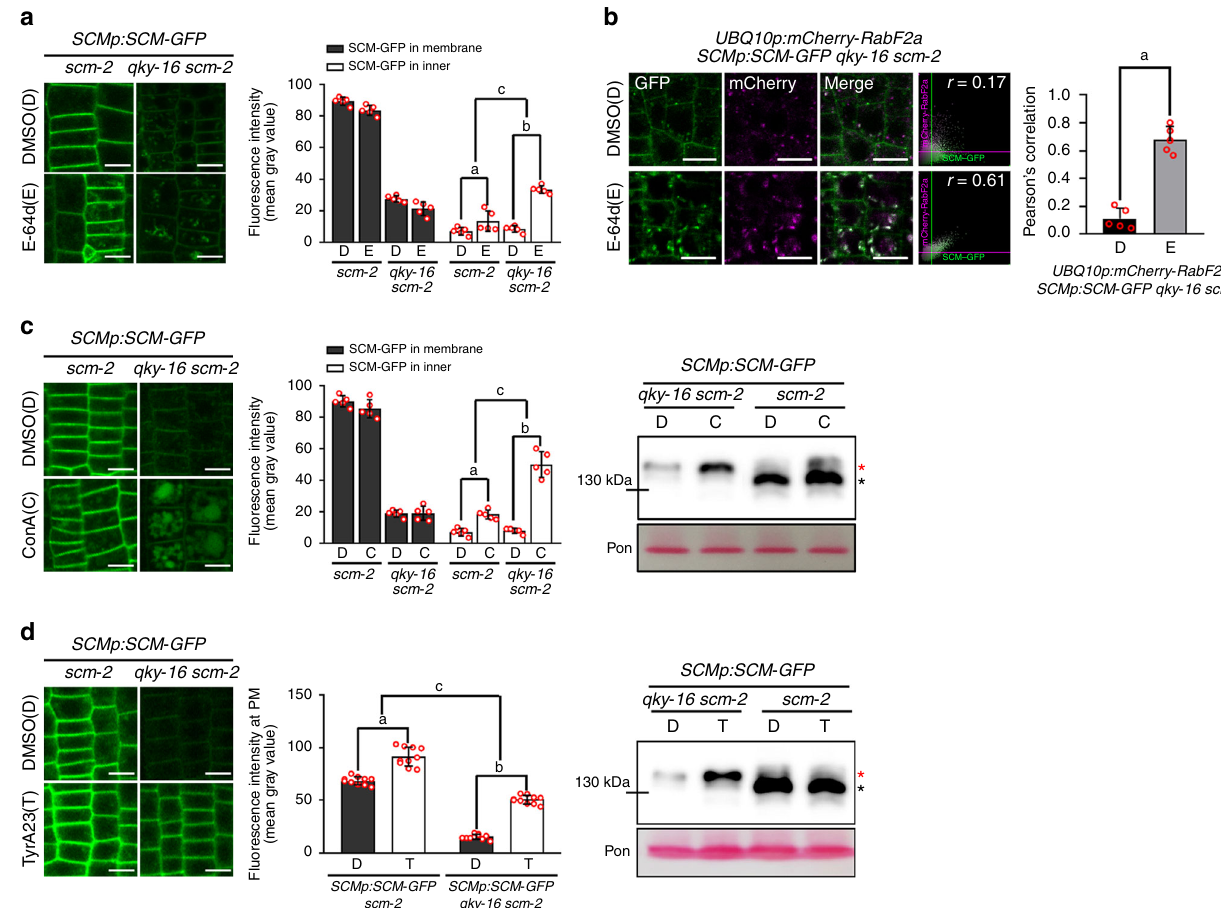
Fig. 6 The internalization of SCM-GFP is regulated by QKY. a Internal accumulation of SCM-GFP after E-64d treatment. Confocal images of the root epidermal cells (left), and the quanti fi ed fl uorescence intensities in the PM and in the inner area (right) are shown. The seedlings were incubated with or without E-64d (20 μ M) for 2 h. P values for a, b, and c are 0.033501792889072, 0.000000031378503, and 0.000051222822657, respectively. Bar = 10 μ m. b Colocalization of internalized SCM-GFP and mCherry-RabF2a. Four-day-old seedlings were treated with or without E-64d (20 μ M) for 2 h. The scatterplots show the Pearson ’ s correlation coef fi cient ( r ) between these two fl uorescent signals. Typical examples of images and scatterplots are shown (left). Average values of the Pearson ’ s correlation coef fi cients from fi ve seedlings are shown in a graph and the error bars indicate standard deviations (right). Statistical signi fi cance was determined by unpaired t test, and P values for a is 0.000006164460956. Bar = 10 μ m. c Effect of ConA on the SCM- GFP level. Four-day-old seedlings of the two plant lines were incubated with or without ConA (200 nM) for 9 h. Confocal images show internal accumulation of SCM-GFP (left) and the fl uorescence intensities in the PM and in the inner area were quanti fi ed (middle). The level was also analyzed by western blot (right). P values for a, b, and c are 0.002510271018002, 0.000000000221023, and 0.000001097753466, respectively. Bar = 10 μ m. d Effect of TyrA23 on the SCM-GFP protein level. Four-day-old seedlings of the two plant lines incubated with or without TyrA23 (100 μ M) for 10 h. Confocal images show SCM-GFP accumulation (left) and the fl uorescence intensity in the PM was quanti fi ed (middle). The level was also analyzed by western blot (right). P values for a, b, and c are 0.000000000079707, below 0.000000000000001, and 0.000651871734356, respectively. Bar = 10 μ m. The asterisks in ( c ) and ( d ) indicate two different bands reacting with anti-GFP antibodies. Statistical signi fi cance was determined by two-way ANOVA with Bonferroni ’ s post hoc test ( a , c , d ). Values represent means ± SD of fi ve individual 4-day-old seedlings for ( a , c ) and of ten seedlings for ( d ). In each seedling, ten cells were antibodies, and analyzed its gel mobility and ubiquitination To identify the ubiquitination sites in the SCM protein, we (Fig. 7e). This SCM K520/525/526R -GFP showed similar mobility to analyzed the gel mobility of mutant versions of SCM-GFP with that of nonubiquitinated SCM-GFP and did not react with anti- single or multiple lysine residues replaced by arginine residues and ubiquitin antibodies (P4D1) (Fig. 7e). These results suggest that expressed transiently in qky-16 mutant leaves (Supplementary SCM is modi fi ed by multi-monoubiquitination and that these Fig. 8). The SCM-GFPs with a substitution of Lys-520, Lys-525 or three residues (Lys-520, and at least one from Lys-525 and Lys- Lys-526, and two substitutions at Lys-525 and Lys-526 showed 526) represent the ubiquitination site. intermediate gel mobility (between the mobility of wild-type SCM-GFP in the qky-16 mutant and the wild type), and SCM-GFPs with two substitutions at Lys-520 and Lys-526 Discussion showed similar mobility to that of nonubiquitinated SCM-GFP. Therefore, we changed all three of these lysine residues to alanine SCM, an atypical LRR RLK, is a critical regulator of cell-type (SCM K520/525/526R -GFP), expressed this construct transiently in patterning in the Arabidopsis root epidermis 16 . However, the qky-16 mutant leaves, immunoprecipitated with anti-GFP mechanism and regulation of SCM action had been unclear prior